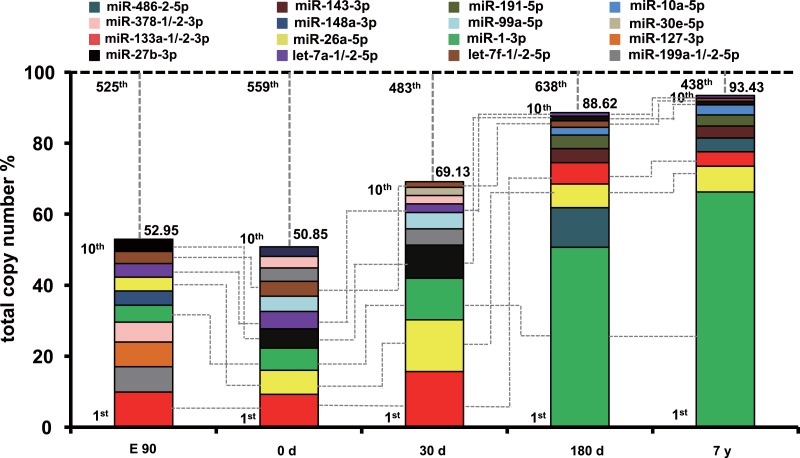
Top 10 unique miRNAs with the highest expression levels during the five muscle development stages.Plot of the unique miRNAs versus their total copy number % of all unique miRNAs for each library. The dashed vertical lines represent the cumulative % of the top 10 unique miRNAs in total counts of all unique miRNAs. The 6 miRNAs that are present in the top 10 miRNAs in all libraries are connected by lines.